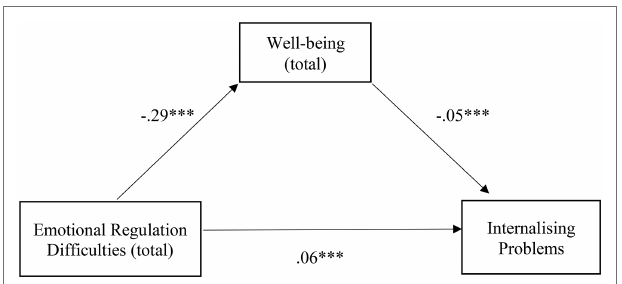
FIGURE 1 | Illustration of the direct effects of emotional regulation difficulties for internalizing problems through the mediator well-being. The represented coefficients are standardized. Total effect ( β = 0.07, p < 0.001). *** p < 0.001.